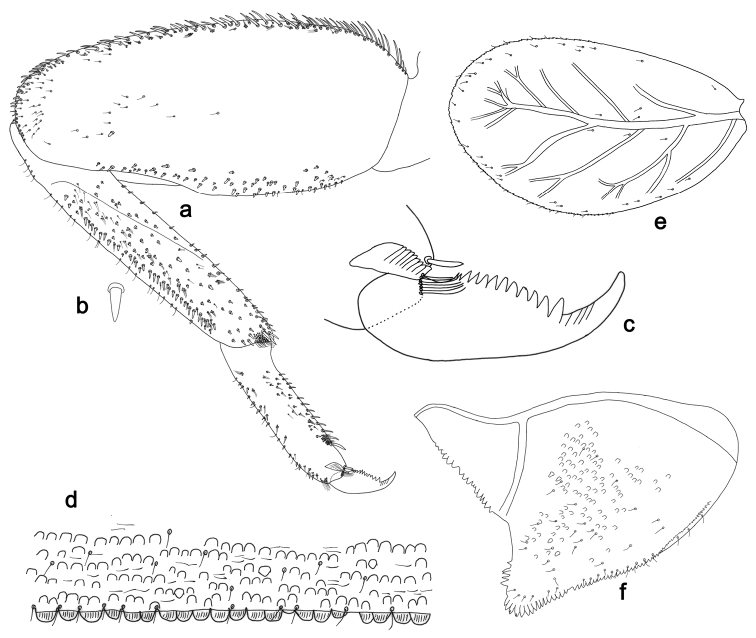
Labiobaetiselisae sp. n., larva morphology: aForelegb Tibia dorsal seta c Fore claw dTergum IV e Gill IV fParaproct.